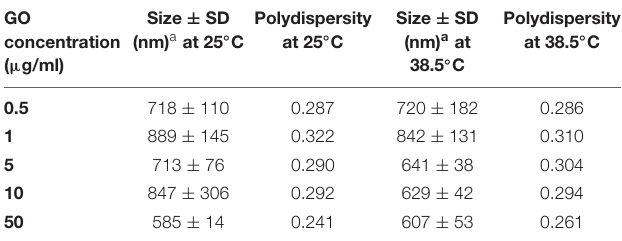
TABLE 1 | Chemical characterization of GO solution at different